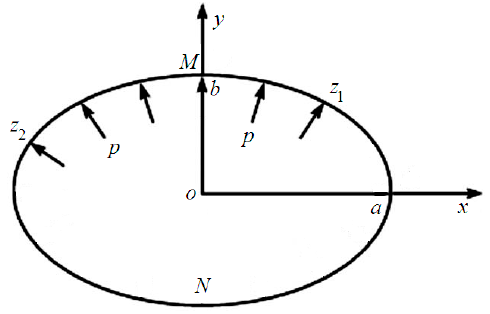
Figure 1. A schematic figure for an elliptic notch.